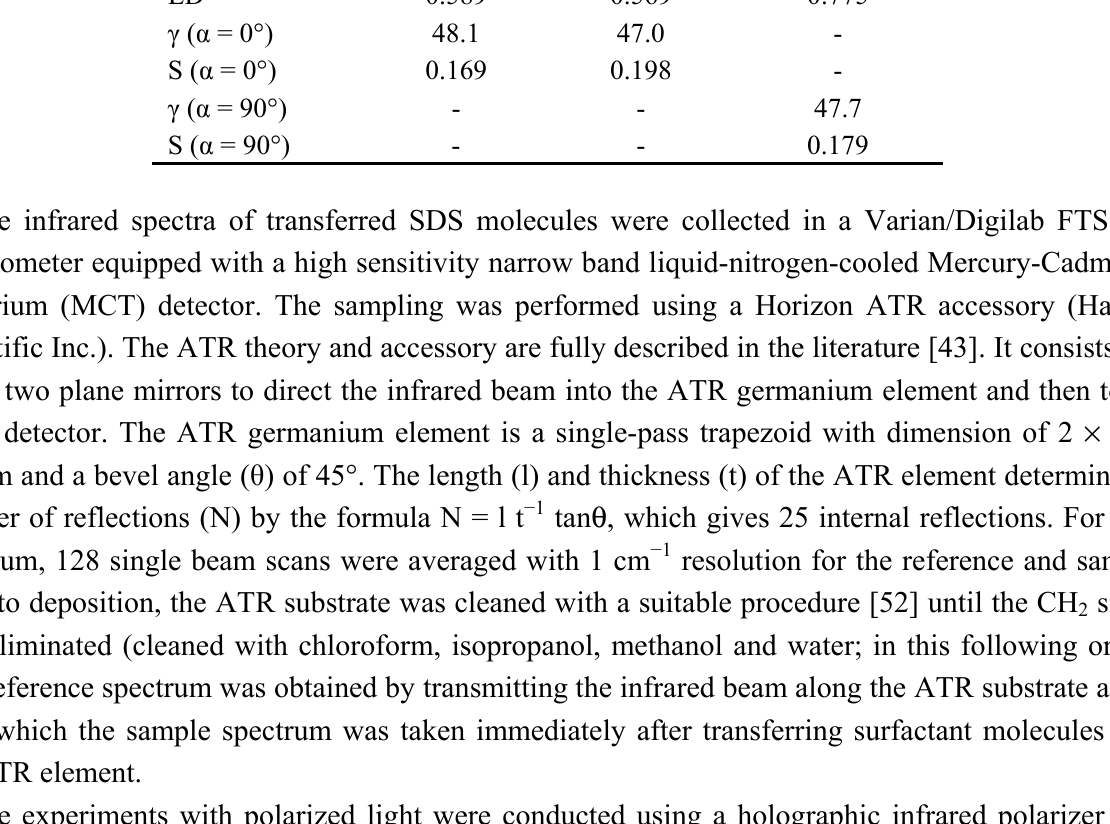
asymmetric ( ν ), CH symmetric ( ν ), and CH 2 a 2 s 3